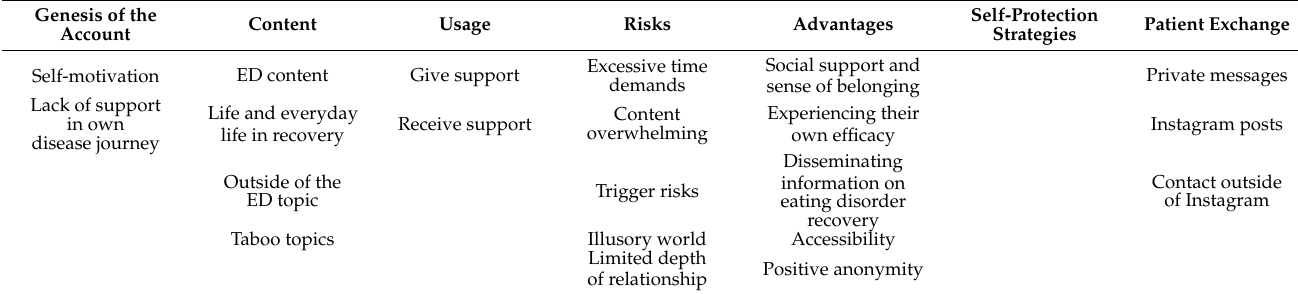
Table 3. Overview